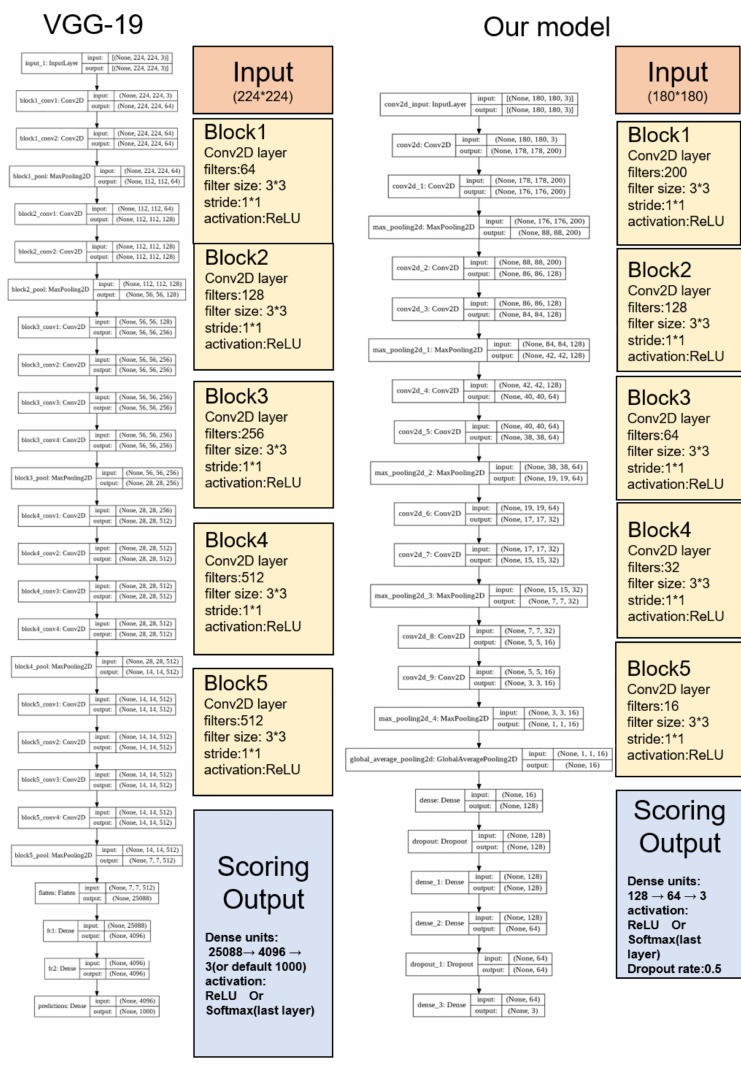
Figure 2. A modified network structure based on VGG-19. The low precision of REM using the existing algorithm is due to imbalanced multiclass classification sleep datasets. The ratio of the three stages of the ordinary mouse is approximately 10 : 10 : 1 (wake:NREM:REM) under the conventional experimental conditions. The too small sample size of the REM severely reduces the precision of REM, especially on a small-scale dataset [8], which needed to be resolved. Thus, we decided to increase the number of REM